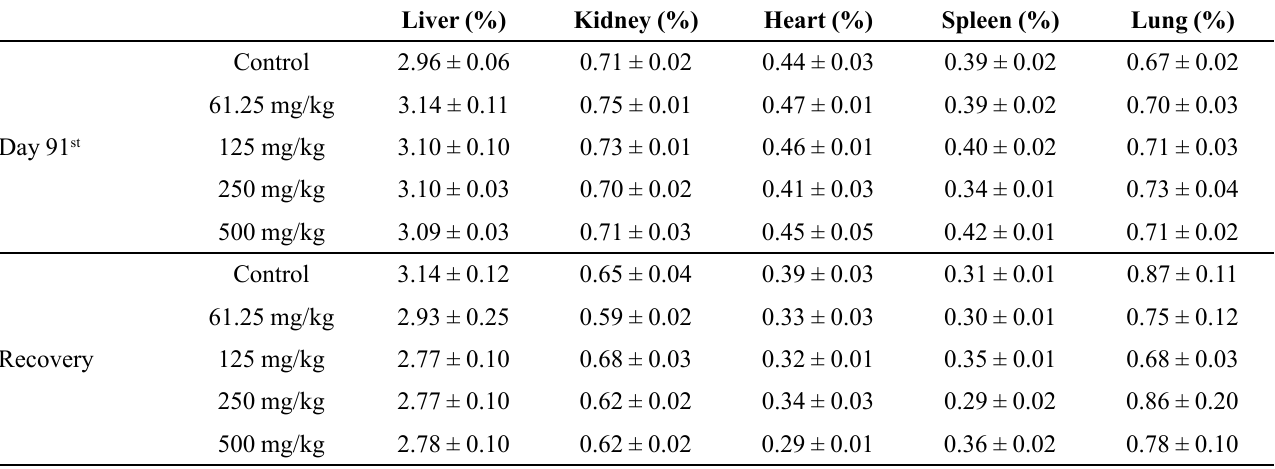
Values are presented as mean ± Standard error of mean (n = 5). p>0.05: Statistically significantly different from control group